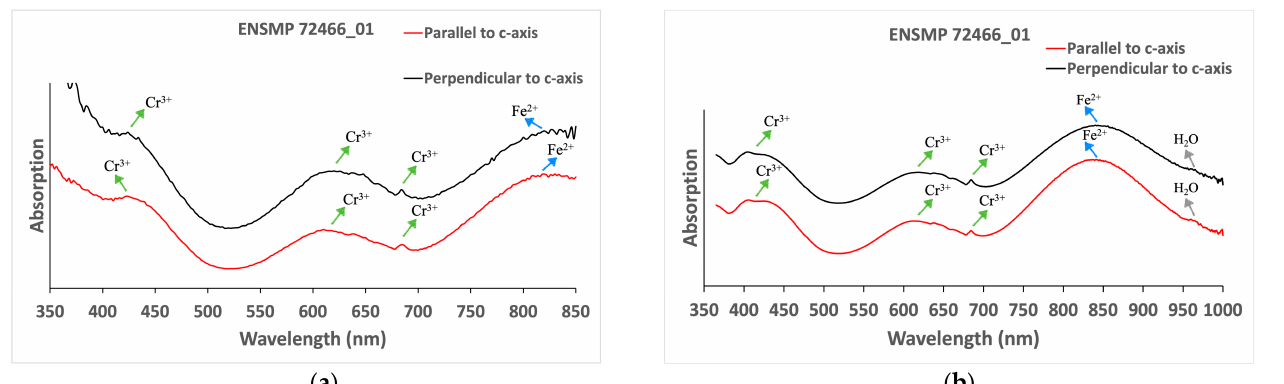
Figure 10. UV-Vis-NIR spectra of an Egyptian emerald single-crystal (ENSMP 72466_01). ( a ) UV-Vis spectra parallel (red line) and perpendicular (black line) to c-axis. The main chromophore elements are chromium and iron. ( b ) Vis-NIR spectra with the mobile instrument parallel (red line) and perpendicular (black line) to c-axis. Additional bands related to water molecules can also be observed at around 960 nm.